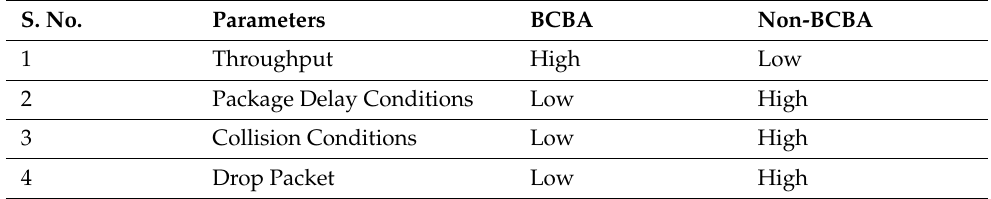
Table 3. A list of system performance factors.